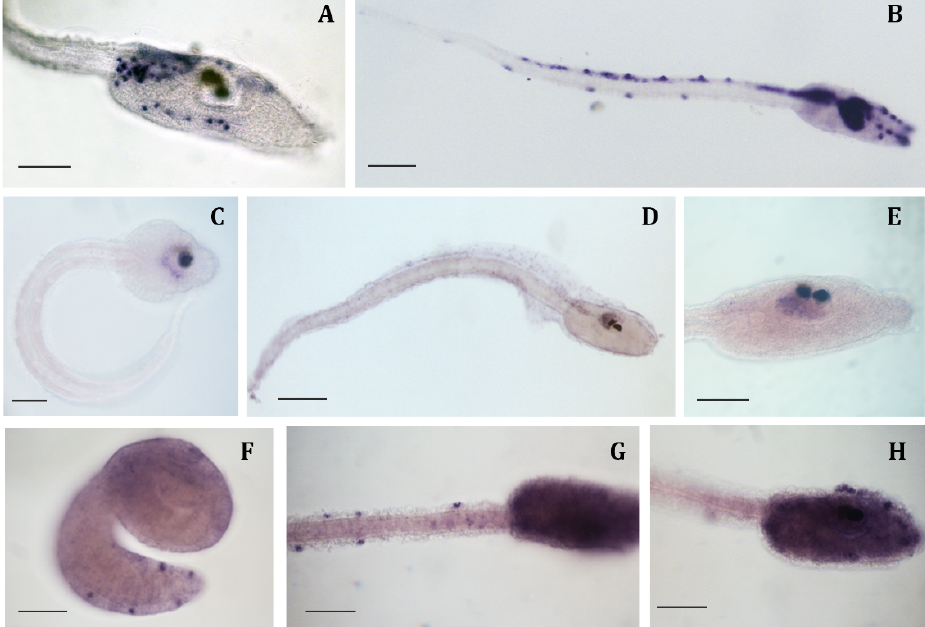
Figure 2. Whole mount in situ hybridization of C. intestinalis embryos. ( A ) Unspecific stain in mesenchymal cells of larva trunk, obtained when hybridization with LNA probes was